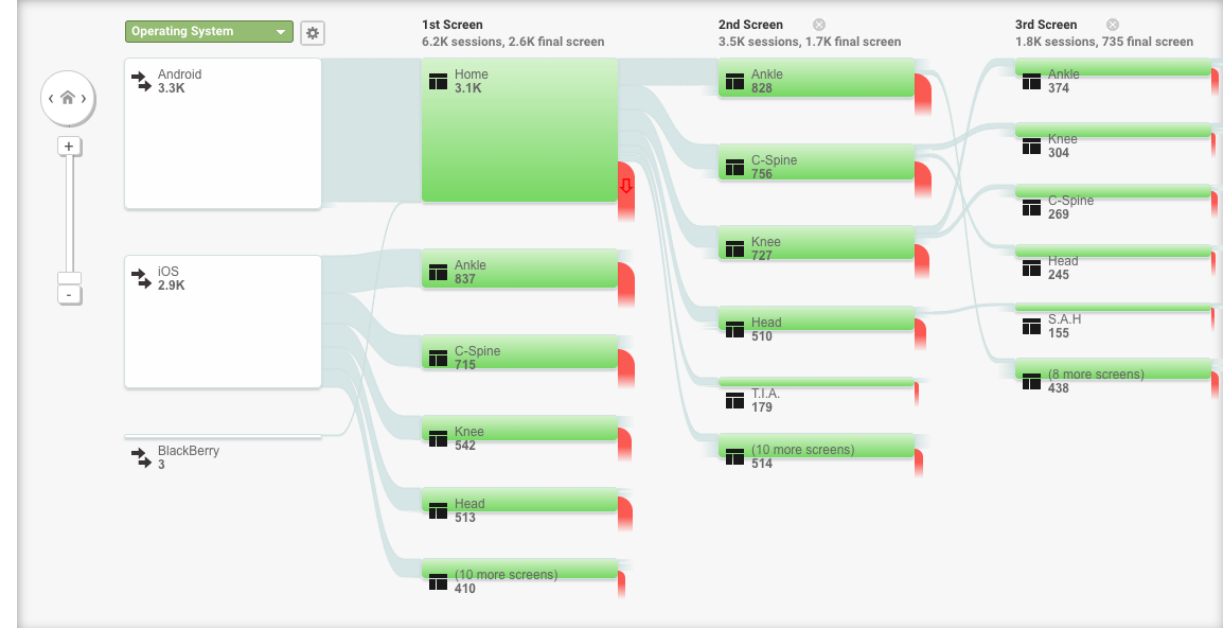
Figure 3. Behaviour flow diagram stratified by user operating